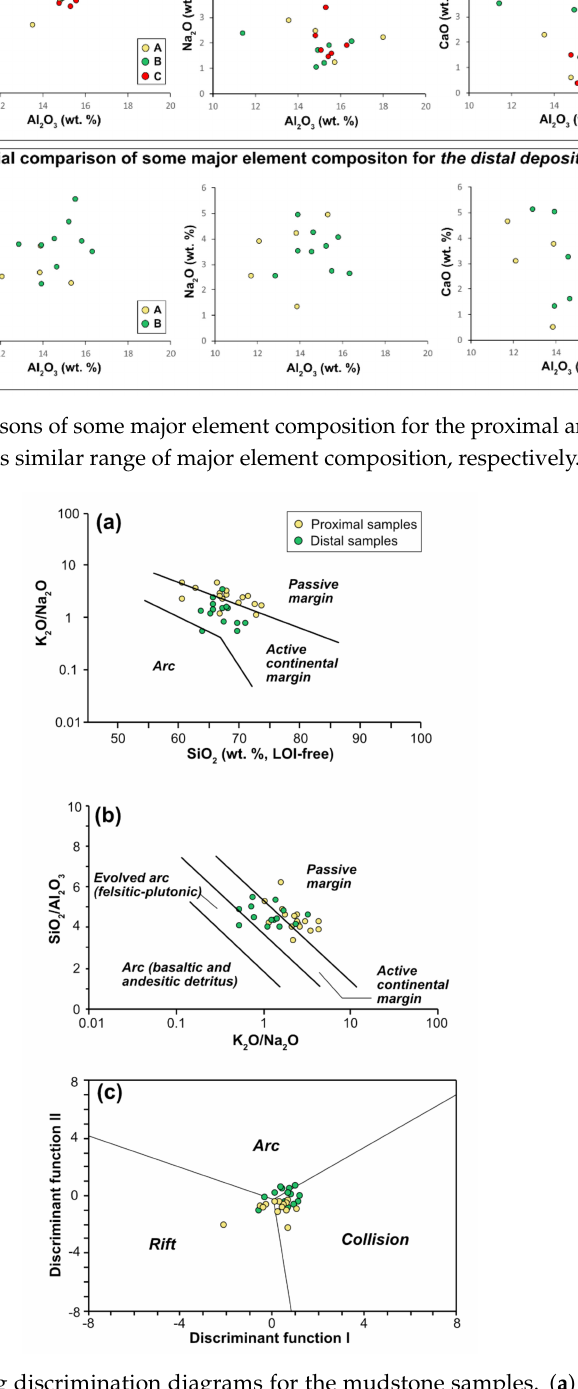
Figure 9. Tectonic setting discrimination diagrams for the mudstone samples. ( a ) K 2 O / Na 2 O–SiO 2 diagram [7]. ( b ) SiO 2 / Al 2 O 3 –K 2 O / Na 2 O diagram [7] ( c ) Discriminant function diagram for high-silica [(SiO 2 ) adj = 63–95%] samples [41], where (SiO 2 ) adj refers to the modified SiO 2 value after volatile-free recalculation of the major elements to 100%. Two mudstone samples classified as low-silica [(SiO 2 ) adj = 35–63%] are plotted in the rift field (not presented). The proximal and distal deposits are plotted in these tectonic setting discrimination diagrams separately with minor